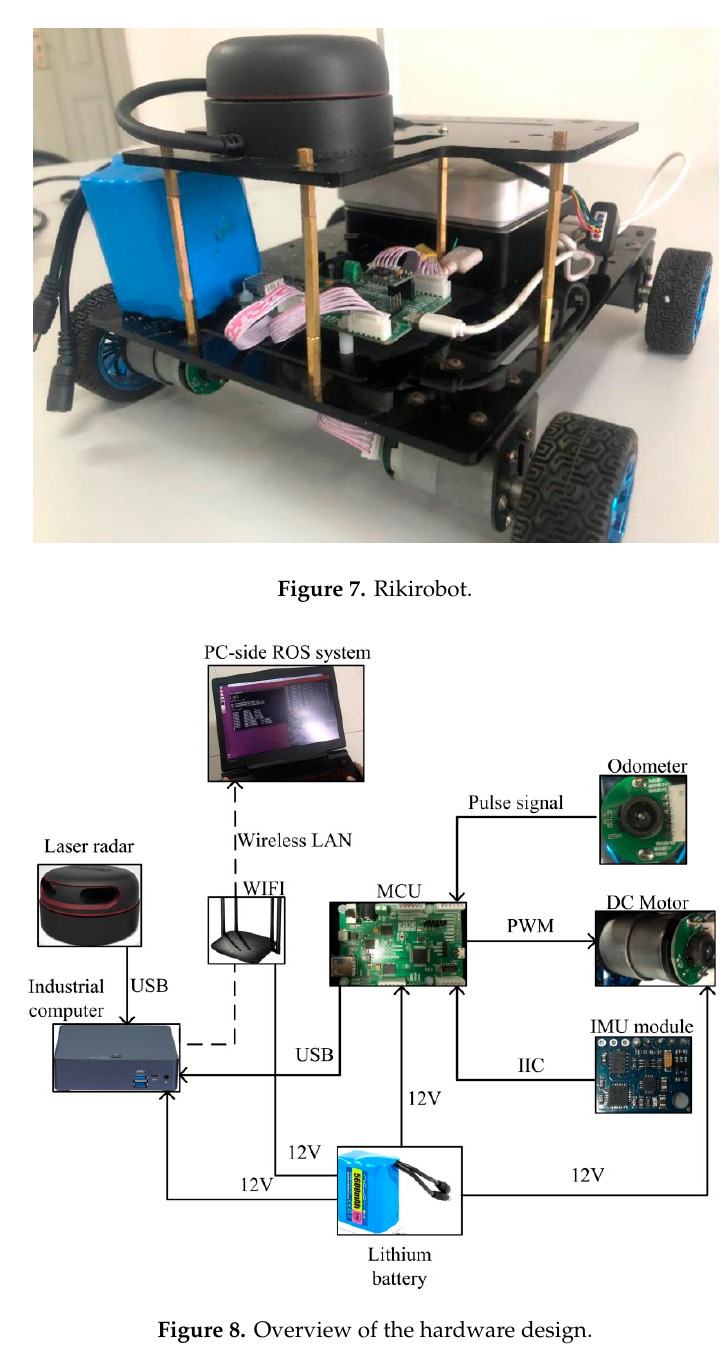
Figure 8. Overview of the hardware design.